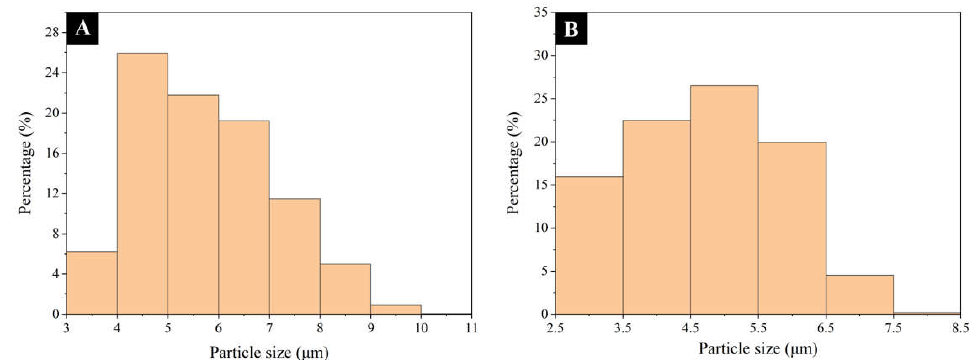
Figure 3. Particle size distribution of ( A ) thermochromic microcapsules and ( B ) photochromic mi- crocapsules.